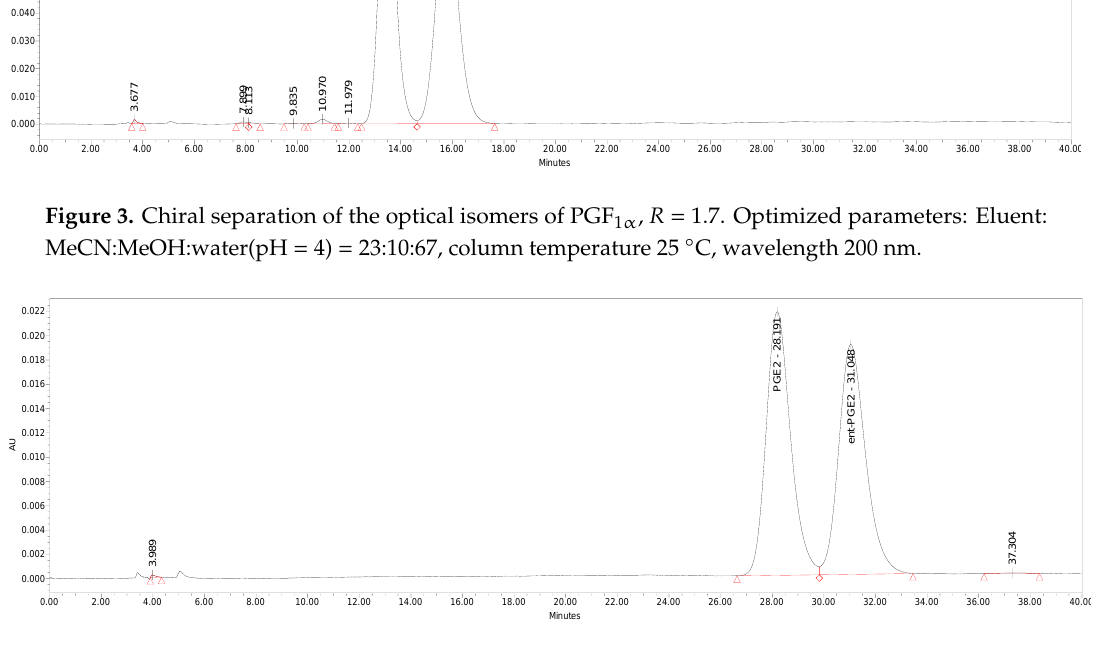
Figure 4. Chiral separation of the optical isomers of PGE 2 , R = 1.5. Optimized parameters: Eluent: